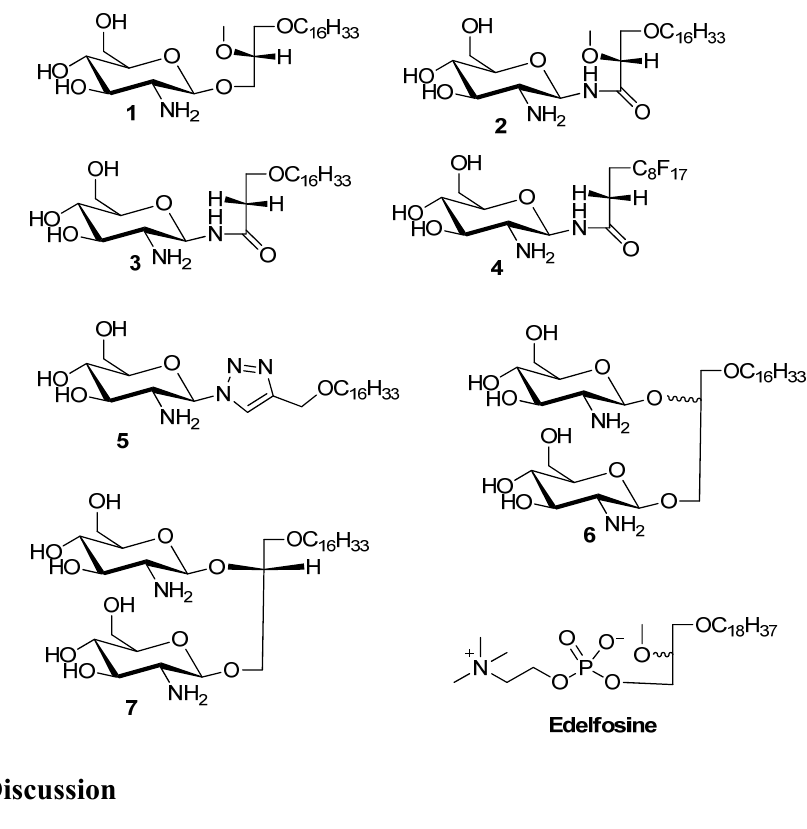
Figure 1. Structures of the synthesized glycolipids used in the study. Compound 1 is the reference GAEL while compounds 2 – 5 are glycolipid analogs differing in the nature of the glycosidic linkage and glycerol moiety. Compounds 6 and 7 are glycolipid analogs where the glycerolipid moiety contains two glycosidic linkages. Edelfosine is shown as a prototypic AEL